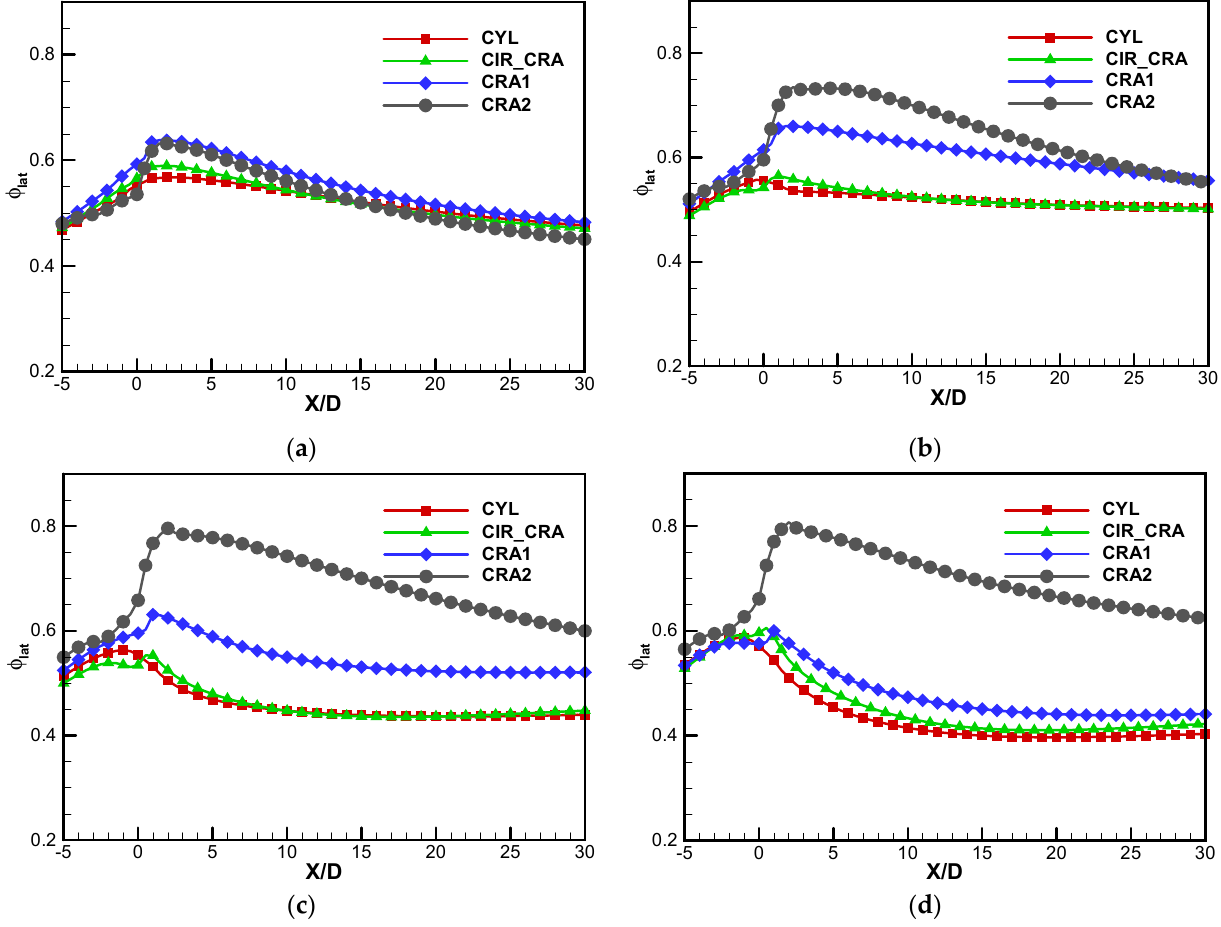
Figure 10. Laterally averaged overall cooling effectiveness profiles at various blowing ratios. ( a ) M = 0.5; ( b ) M = 1.0; ( c ) M = 1.5; ( d ) M = 2.0.